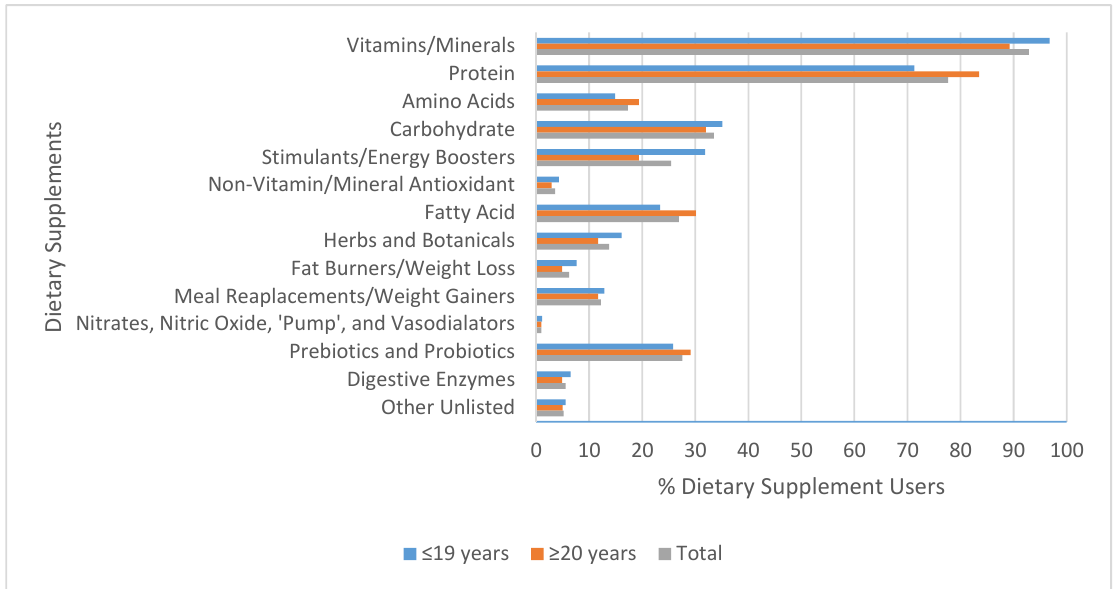
Figure 1. Percentage (%) of supplement users using different dietary supplements based on age ( n = 94 for ≤19 years; n = 103 for ≥20 years; and n = 197 for total).